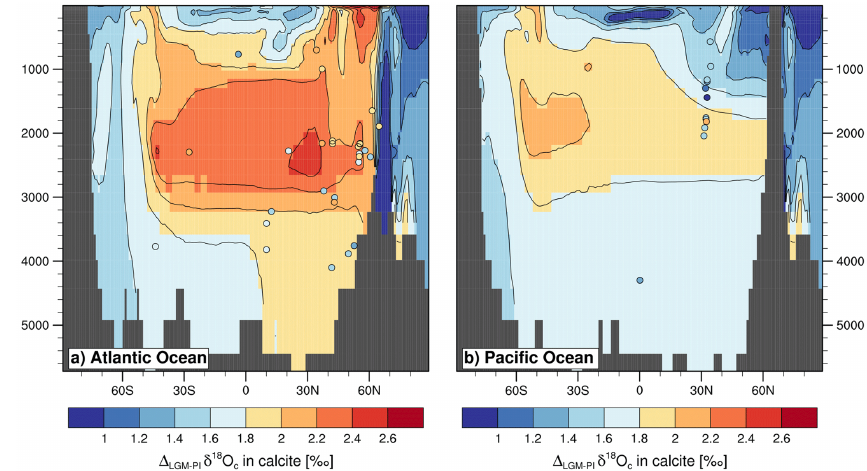
Figure 11. Background pattern: meridional section of the simulated annual mean LGM-PI δ 18 O c in calcite changes in (a) the Atlantic (zonal mean over 60 to 0 ◦ W) and (b) the Pacific (zonal mean over 150 ◦ E to 110 ◦ W). Geographically related data entries from a compilation of 115 LGM–Late Holocene δ 18 O c anomalies of benthic foraminifera data compiled by Caley et al. (2014b) are plotted as coloured symbols (Atlantic Ocean: n = 29; Pacific Ocean: n = 12) in each panel.